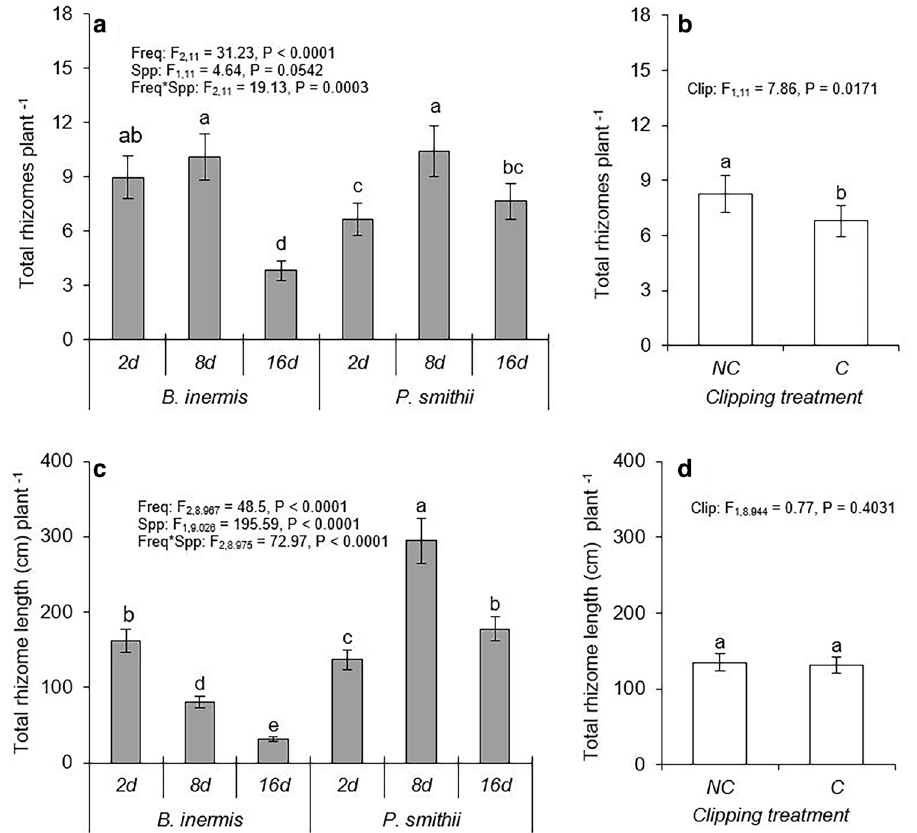
Figure 2. Effect of precipitation frequency and clipping on number of total rhizomes ( a , b ) and total rhizome length ( c , d ) per plant of Bromus inermis and Pascopyrum smithii . Values are mean ± SE based upon the statistical model. Significant differences at p -value < 0.05 indicated by different letters. Interaction results are shown when p -value < 0.05. Full results are shown in Table S2 and S3.